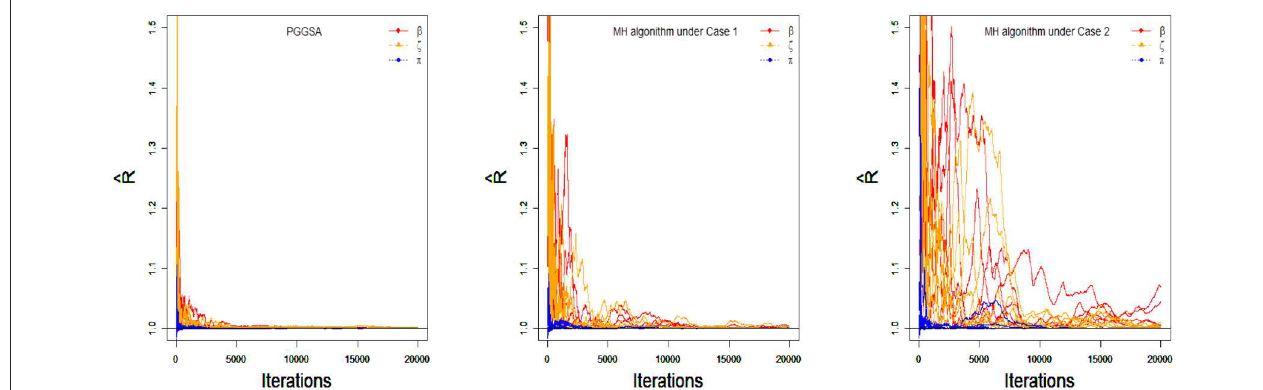
FIGURE 4 | The trace plots of PSRF values for the simulation study